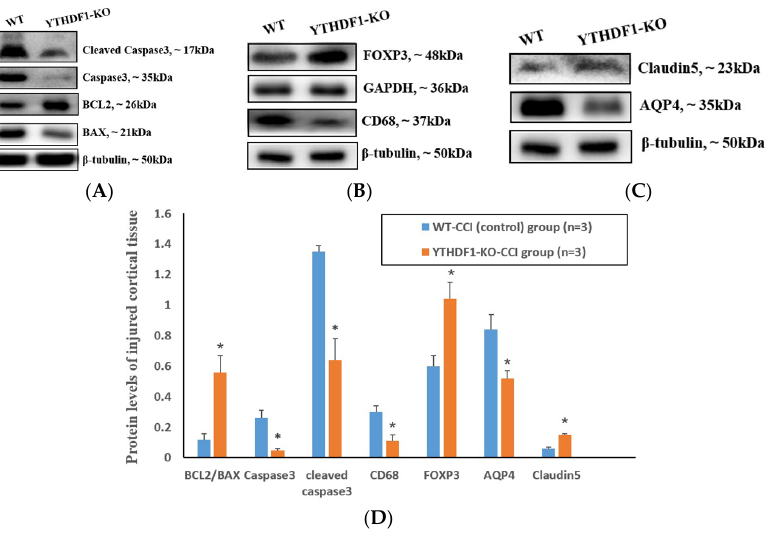
Figure 3. Western blots showed that YTHDF1-knockout markedly affected the apoptosis, inflamma- tion, and oedema protein levels in injured cortical tissues at 3 days post-CCI. (BCL2, BAX, Caspase3, Cleaved caspase3, CD68, AQP4, and Claudin5 were normalized to β -tubulin, while FOXP3 was normalized to GAPDH). ( A ) The pro-apoptosis protein (BAX, Caspase3, and Cleaved caspase3) level was decreased, while the anti-apoptosis protein (BCL2) level was increased in the YTHDF1- knockout group compared to the WT group. ( B ) The pro-inflammation protein (CD68) level was markedly decreased and the anti-inflammation protein (FOXP3) level was significantly increased in the YTHDF1-knockout group compared to the WT group. ( C ) The pro-oedema protein (AQP4) level was markedly decreased and the anti-oedema protein (Claudin5) level notably increased in the YTHDF1-knockout group compared to the WT group. ( D ) Grayscale analyses of WB bands of BCL2/BAX, Caspase3, Cleaved caspase3, FOXP3, CD68, AQP4, and Claudin5 were quantified. Values are means ± SEs. * p <